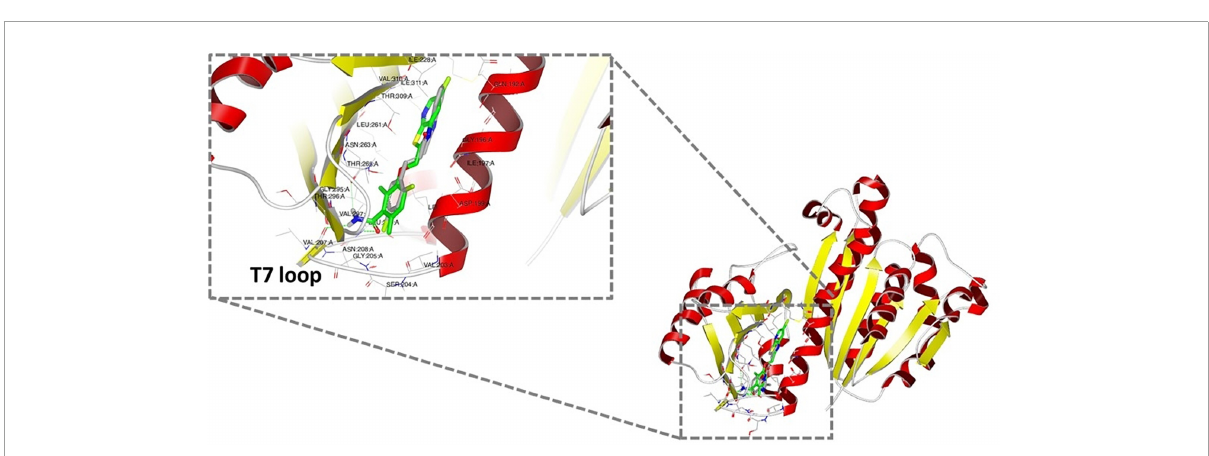
FIGURE6 Docking analysis of the predicted binding of cinnamaldehyde analogs to FtsZ In silico docking studies were performed using OpenEye Scientific Software (McGann, 2012). Molecular binding of LXC 31 (6; gray) is shown above alongside co-crystallized FtsZ inhibitor PC190723 (green; PDB 3VOB) (Matsui et al., 2012). Binding poses for compounds 1 to 6 are shown in Supplementary Figure 4 . In each case, the lowest energy pose of the lowest energy conformer is